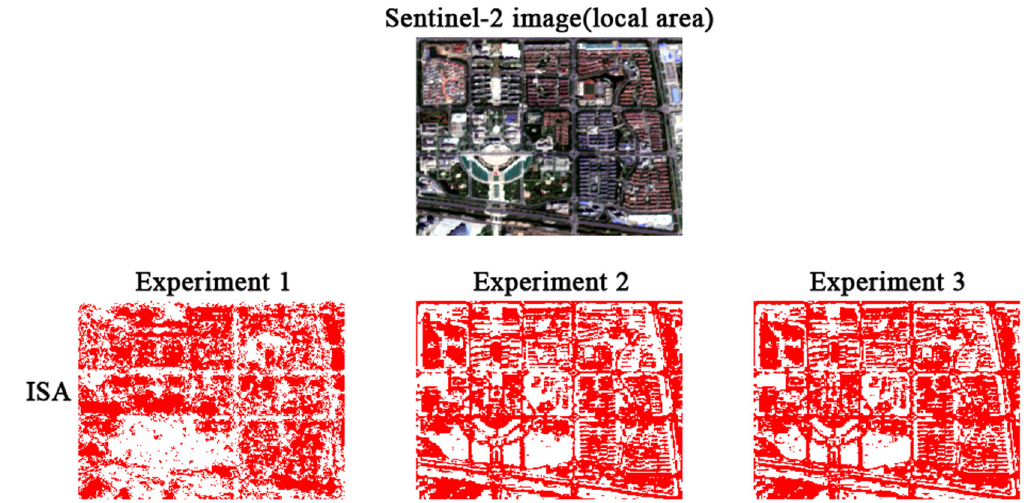
Figure 6. ISA Classification results for different feature sets.